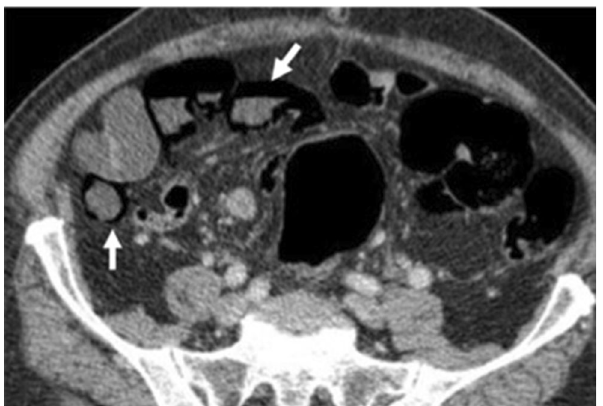
Fig. 11 Pneumatosis. A 91-year-old male with mesenteric infarction. Contrast-enhanced CT images of the lower abdomen show gas in the bowel wall (white arrow)